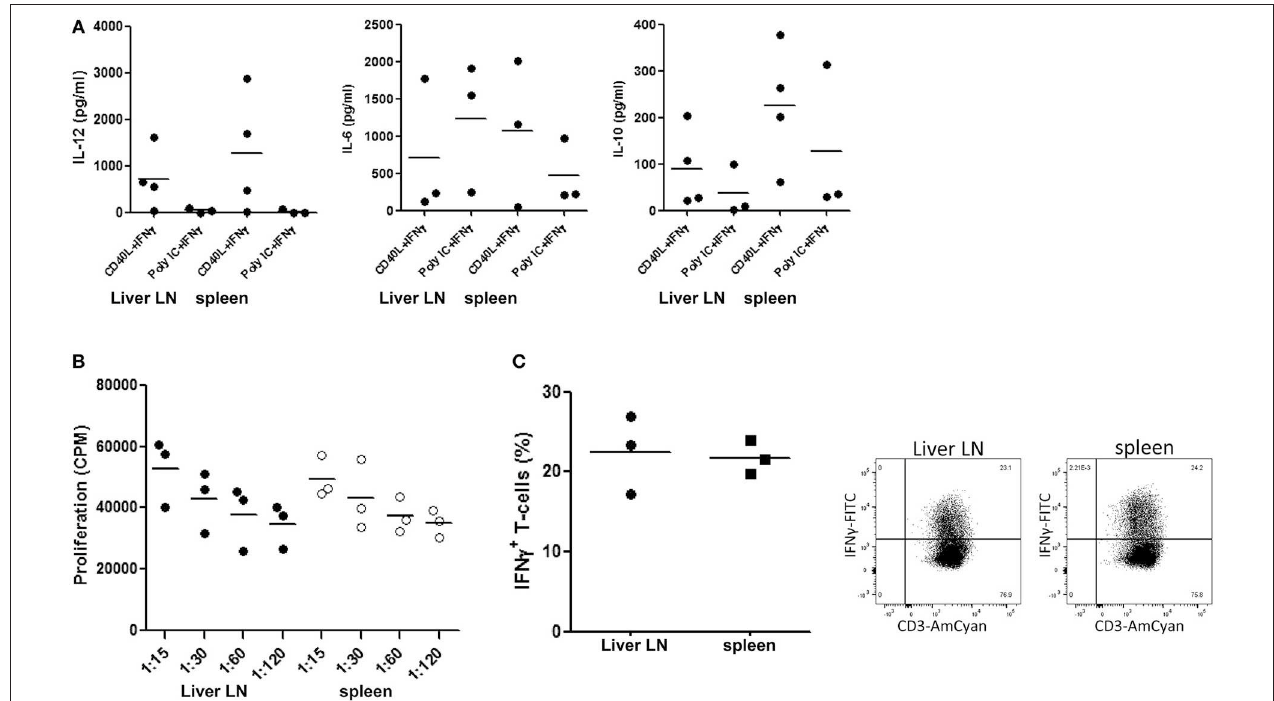
FIGURE 3 | cDC2 isolated from hepatic lymph nodes and spleen are functionally similar. (A) cDC2 were purified from hepatic LN and spleen MNC from the same donors by immunomagnetic depletion of granulocytes, T cells and B cells followed by flowcytometric sorting of CD1c + CD14 − CD20 − cells as described in the Methods section, and 2 × 10 4 cells/200 µ l were stimulated with either CD40L-transfected plasmacytoma cells (2 × 10 4 J558 cells) and 1,000 U/ml IFN- γ , or with 20 µ g/ml poly IC and 1,000 U/ml IFN- γ for 24h at 37 ◦ C. After 24h, supernatants were harvested and levels of IL-12, IL-6 and IL-10 were determined. Dots represent data from individual tissues, and lines indicate mean values. (B) Graded numbers of hepatic LN (solid symbols) and spleen (open symbols) cDC2 from the same donors were co-cultured with graded numbers of allogeneic T cells (from one batch) and T-cell proliferation was assessed after 5 days by [ 3 H]-thymidine incorporation. Dots represent data from individual tissues and lines indicate mean values. (C) Naïve allogeneic CD3 + CD45RA + T cells were co-cultured with cDC2 purified from hepatic LN or spleen from the same donors. After 7 days the T-cells were re-stimulated with PMA and ionomycin for 6h. For the last 5h brefeldin A was added. Representative dot plots of intracellular expression of IFN- γ in CD3 + T cells are shown, and a summary of the results from experiments with cDC2 purified from tissues of 3 different donors is depicted. Dots represent data from individual tissues and lines indicate mean